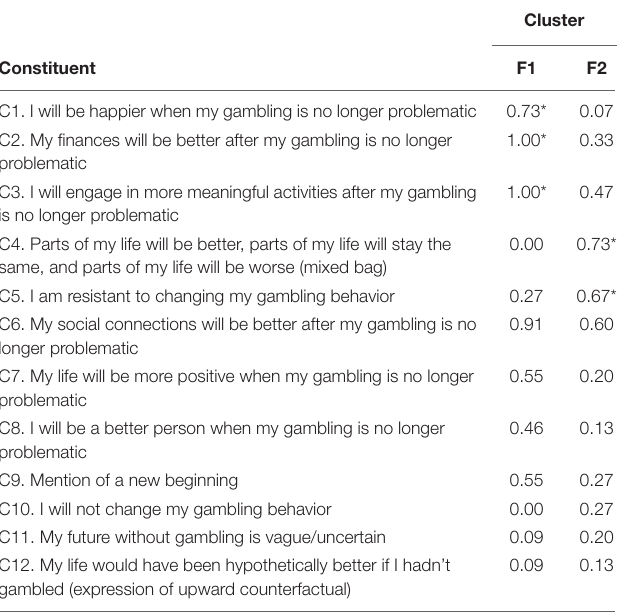
TABLE 4 | Proportion of cluster members expressing each constituent in each of the two clusters in the future